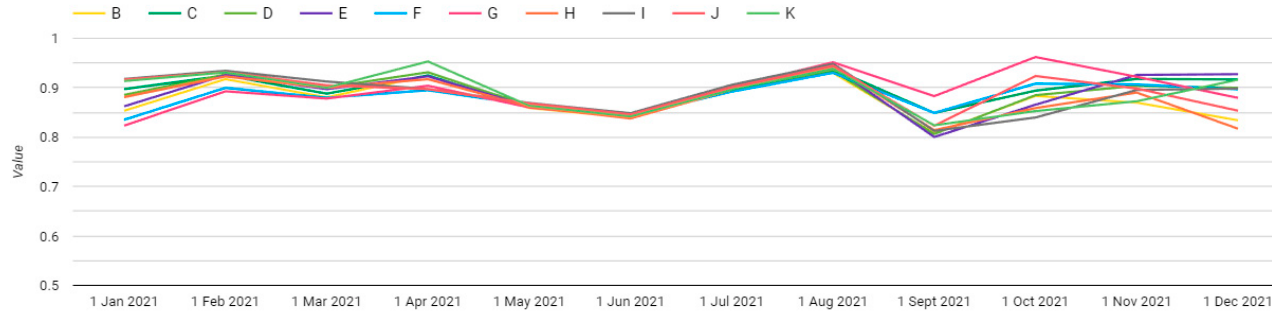
Figure 19. Weather-corrected PR time series of each inverter over the evaluation period.